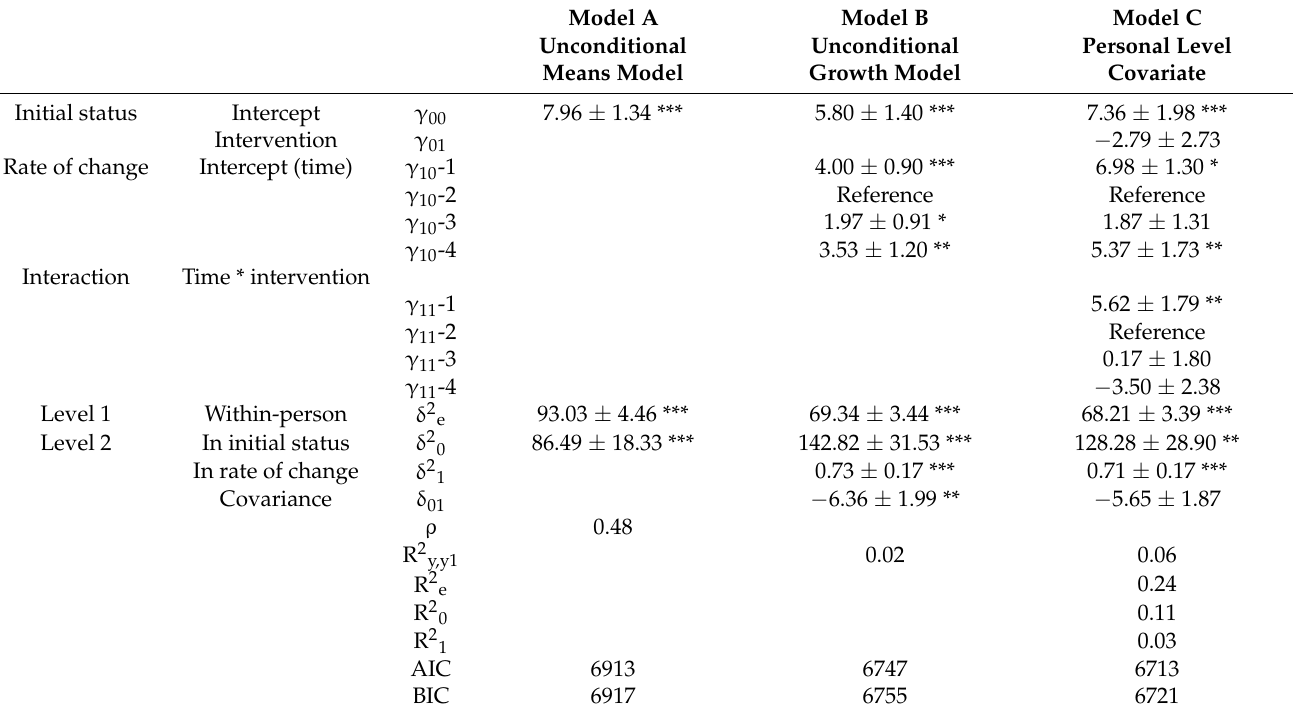
Table 6. Mixed model analyses of variations in vigorous-intensity physical